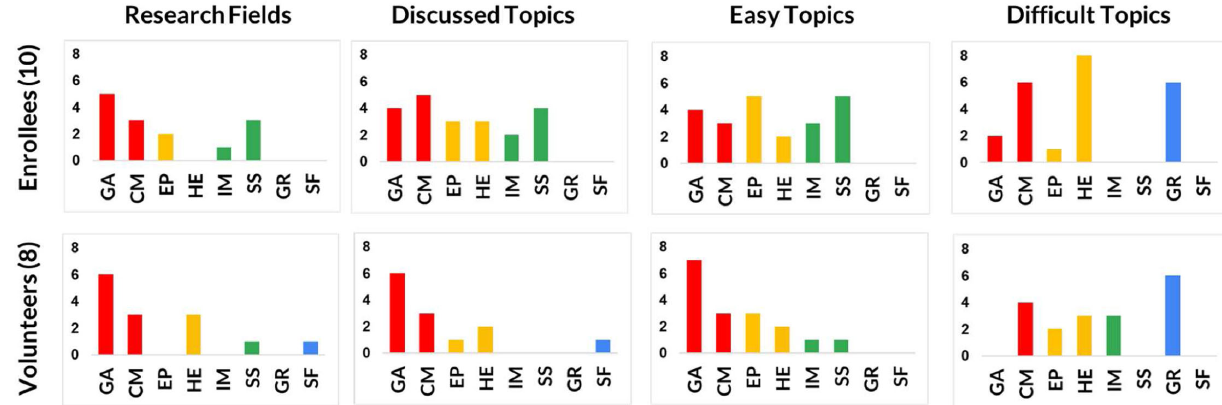
FIG. 3. Bar chart showing the frequency distribution of research fields, discussed topics, topics that are easy, and topics that are difficult for enrollees (top) and volunteers (bottom). The number in the parenthesis refers to the sample size of each participant type. The research fields or topics are Astrophysics of Galaxies (GA), Cosmology and Non-galactic Astronomy (CM), Earth and Planetary Astrophysics (EP), High Energy Astrophysical Phenomena (HE), Instrumentation and Methods for Astrophysics (IM), Solar and Stellar Astrophysics (SS), General Relativity and Quantum Cosmology (GR), and Star Formation (SF). The research fields are based on arXiv ’ s astro-ph section, except for SF, which is answered collectively by 2 attendees in our AC. Topics with bars of the same color are added together to produce a 2 × 4 matrix for a two-tailed Fisher exact test.